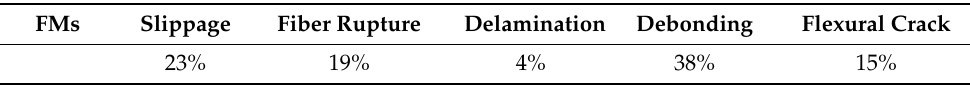
Figure 3. An increase in load-carryifigureng capacity ratio versus: ( a ) number of layers; ( b ) composite type with respect to FMs. Table 4. The percentage of FMs in strengthened beams under flexural behavior in terms of the number of layers.